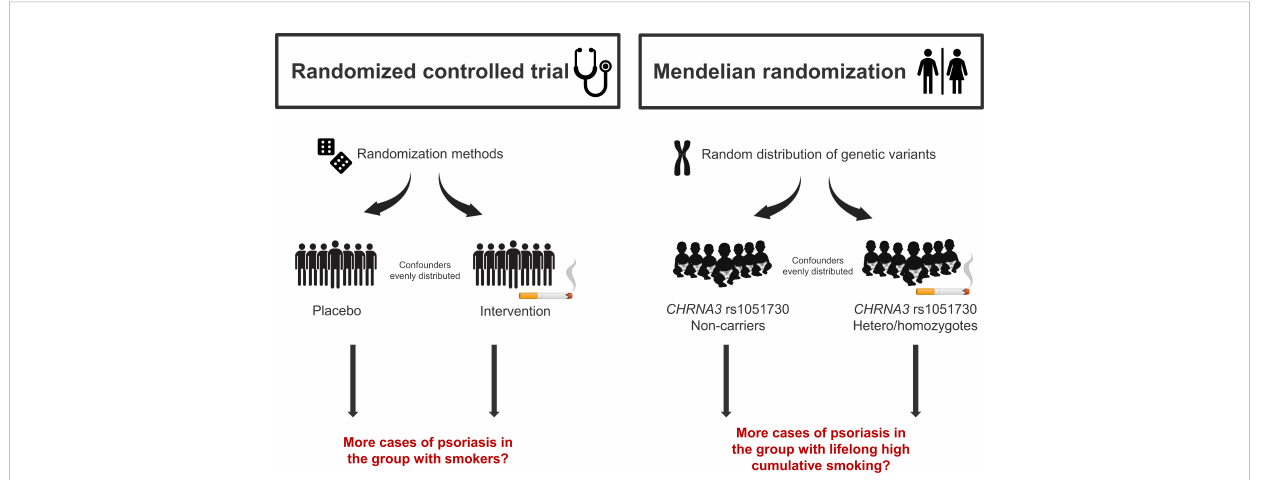
FIGURE 1 Randomized controlled trial vs. Mendelian randomization. A Mendelian randomization study takes advantages of the natural distribution of genetic variants during conception, and therefore mimics the randomized controlled trial. Using the genetic variant CHRNA3 rs1051730, where the T-allele is strongly associated with lifelong high cumulative smoking, as a proxy for smoking, confounding factors are evenly distributed and since genes are present from birth they are not in fl uenced by reverse